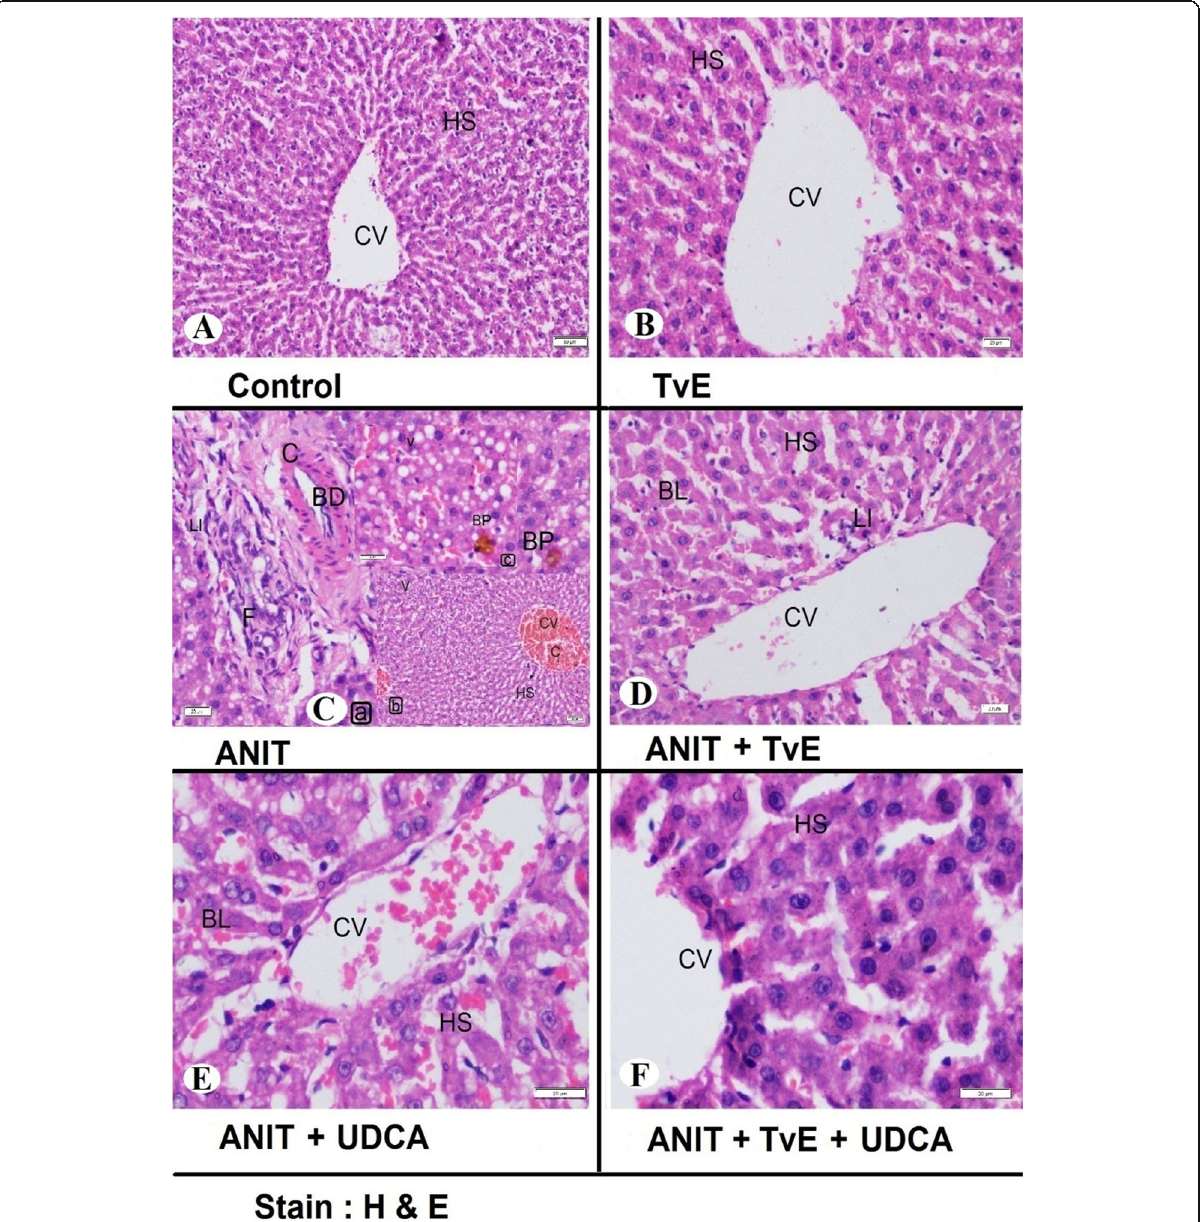
Fig. 2 Photomicrographs of liver tissues in all rat groups stained by hematoxylin and eosin (H&E staining). a Control group showing the normal architecture of the liver with hepatic lobules around the central vein (CV) and each lobule consisting of hepatic strands (HS) of hepatocytes (scale bar = 50 μ m). b (TvE) group showing normal hepatic strands (HS) of hepatocytes around the central vein (CV) (scale bar = 20 μ m). c (C.a) ANIT group showing leukocytes infiltration (LI), fibrosis (F), bilirubin pigment (BP), and congestion (C) in the bile duct (BD). (C.b) showing vaculated cells (V) and severe congestion (C) in central vein (CV). (C.c) showing bilirubin pigment (BP) (scale bar a = 20 μ m, b = 50 μ m, c = 20 μ m). d ANIT + TvE group showing mild hydropic degeneration of hepatocytes around the central vein (CV), bleeding (BL), and leukocytic in filtration (LI) (scale bar = 20 μ m). e ANIT + UDCA group showing normal hepatocytes and mild congestion of central vein (cv) (scale bar = 20 μ m). f ANIT + AIE + UDCA group showing the normal architecture of the liver, with hepatic lobules around the central vein (CV) and each lobule consisting of hepatic strands (HS) of hepatocytes (scale bar 20 μ